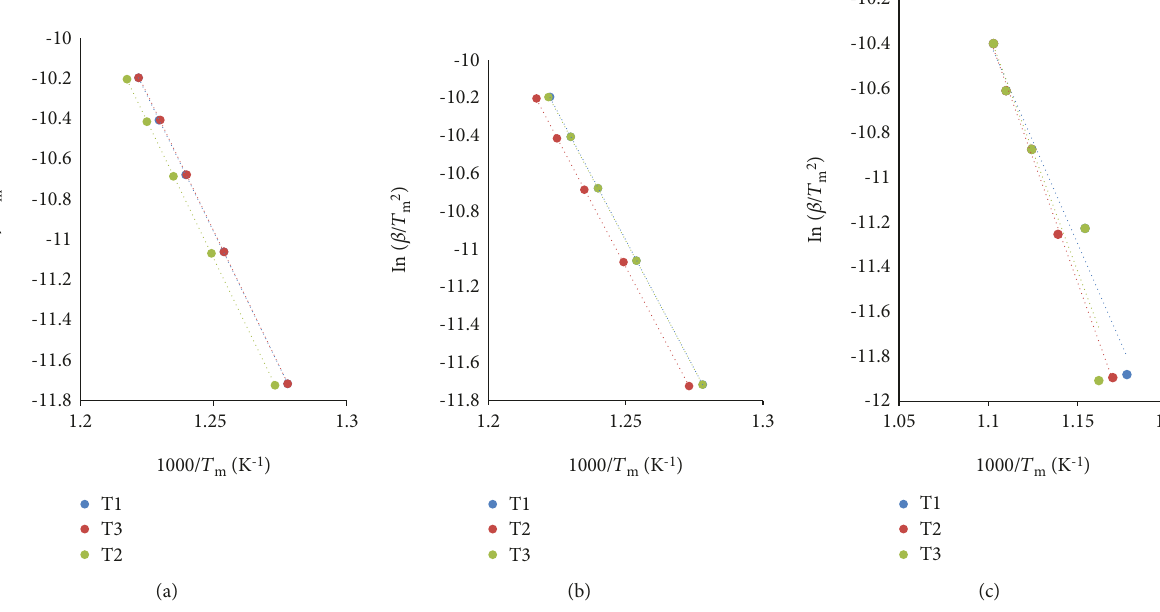
) using Kissinger ’ s method for (a) pre-exposed samples, (b) accelerated weathering, a